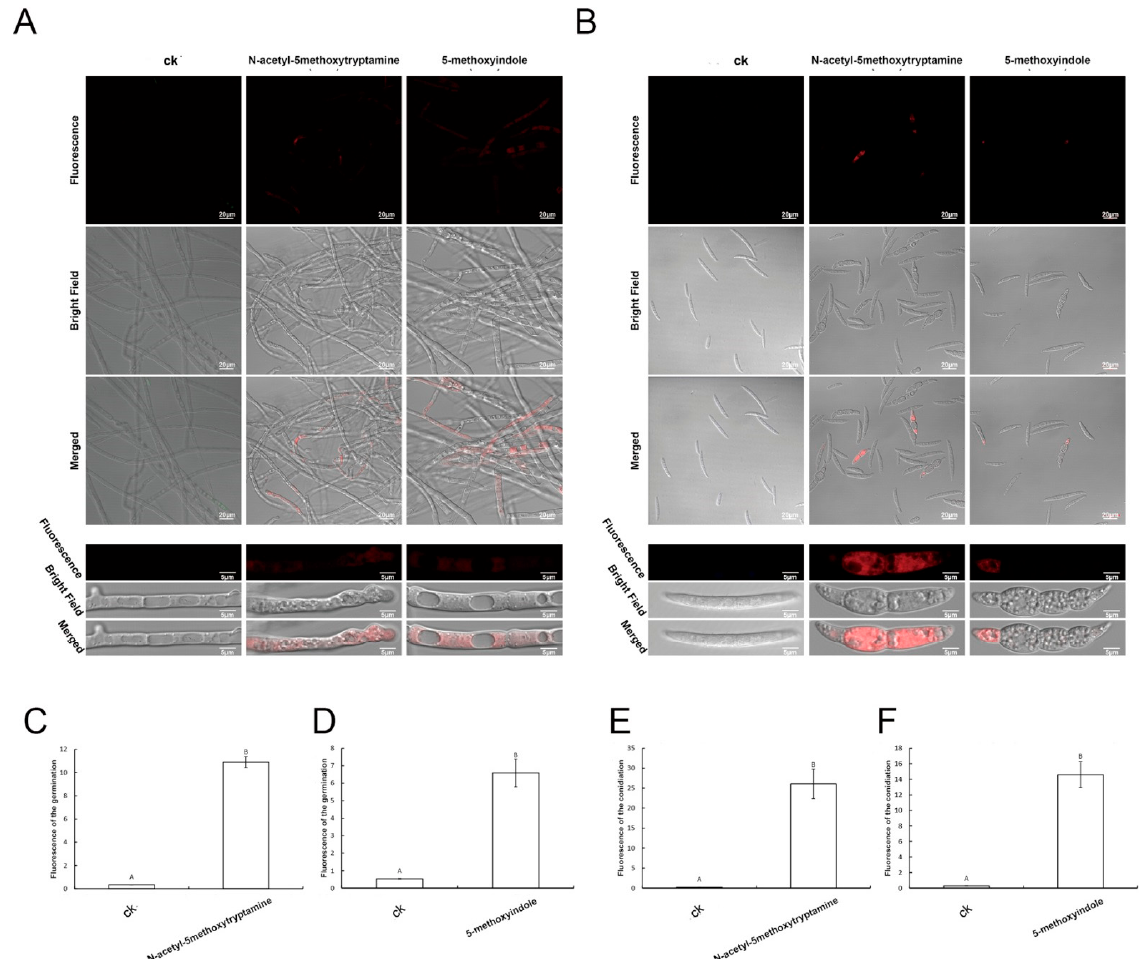
Figure 8. ( A , B ) Detection of F. graminearum hyphae and conidia viability based on propidium iodide staining after treatment with 4 mM melatonin and the 0.1 mM 5-methoxyindole for 3 days. Fungal cells with damaged membranes show red fluorescence; 0.05% (vol/vol) methanol/water served as the ck; ( C , D ) Analysis of the average fluorescence of the F. graminearum hyphae after treating with the melatonin and 5-methoxyindole for 3 days; ( E , F ) Analysis of the average fluorescence of the F. graminearum conidia after treating with the melatonin and 5-methoxyindole for 3 days. The error bars represent the mean standard deviation of each treatment repeated three times with three replicates. The letters above the columns indicate significant differences. The significant difference between the treatments was determined through Tukey’s HSD test at p ≤ 0.05. The higher level of green fluorescence indicates the high level of ROS induction in F. graminearum exposed to the melatonin and